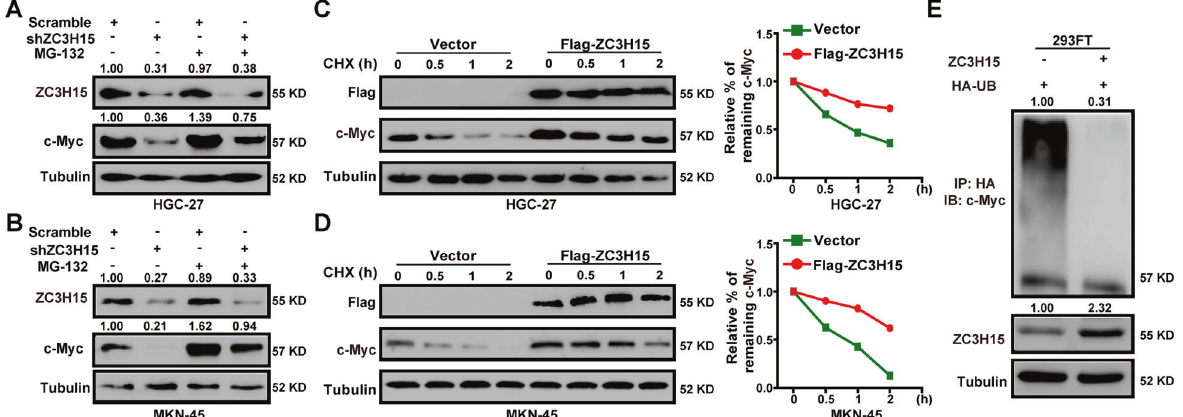
Fig. 5 ZC3H15 stabilized c-Myc by mediating its ubiquitination degradation. A , B ZC3H15-knockdown HGC-27 and MKN-45 cells were treated with or without MG-132 for 8 h before harvesting. Western blot assays were performed to detect the protein expression of ZC3H15 and c-Myc. C , D The c-Myc turnover rate of ZC3H15-overexpression HGC-27 cells and MKN-45 cells was shown. Cells were treated with CHX (100 μ g/ml) for the indicated times and then were harvested for western blot assays. E Transfected cells were treated with MG-132 for 8 h before harvesting. The ubiquitinated c-Myc proteins were pulled down with anti-HA antibody and immunoblotted with anti-c-Myc antibody. All data were expressed as mean ± SD. Student ’ s t -test was performed to analyzed signi fi cance, * P < 0.05, ** P < 0.01, *** P < 0.001. Cell Death Discovery (2022)